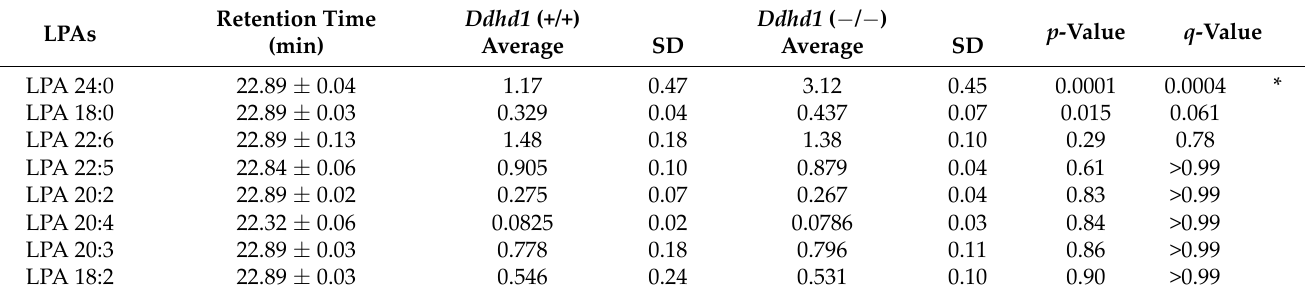
Table 3. LPAs identified from mice